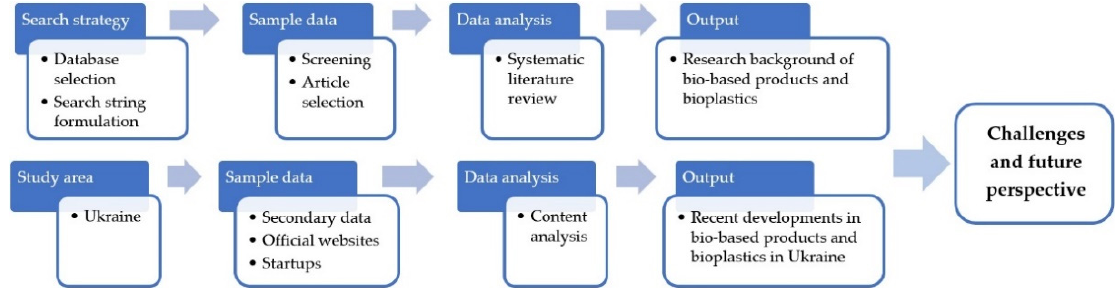
Figure 1. Research framework.